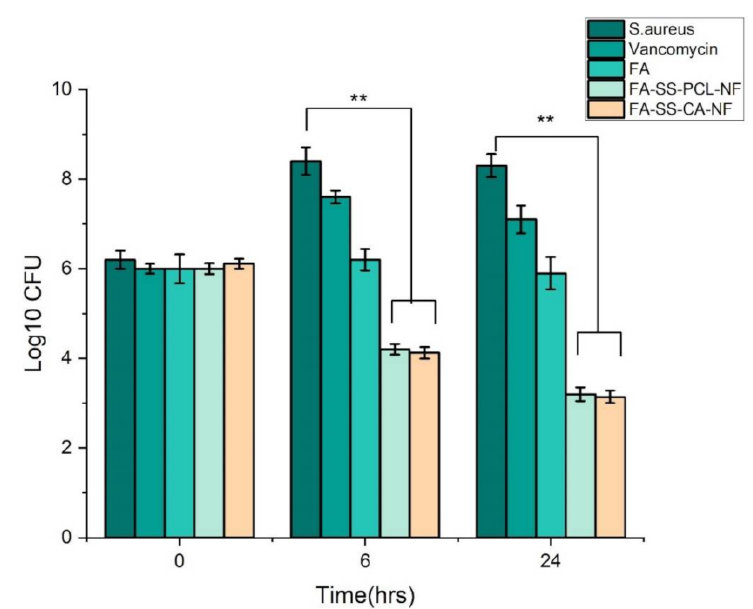
Figure 8. Bar graph of time-kill assay results against Staphylococcus aureus. The error bars indicate the mean ± S.D. ** represent the significant differences between control, drug, and the formulations corresponding to